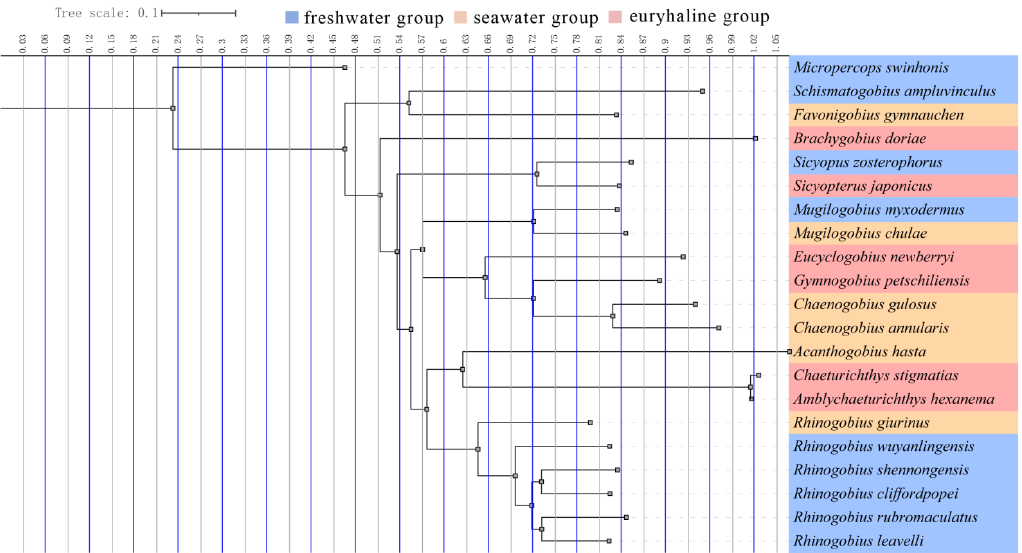
Figure 6. BI tree of all 21 species evaluated in this study based on the 13 mtDNA PCG dataset. Different colors represent different habitat types.